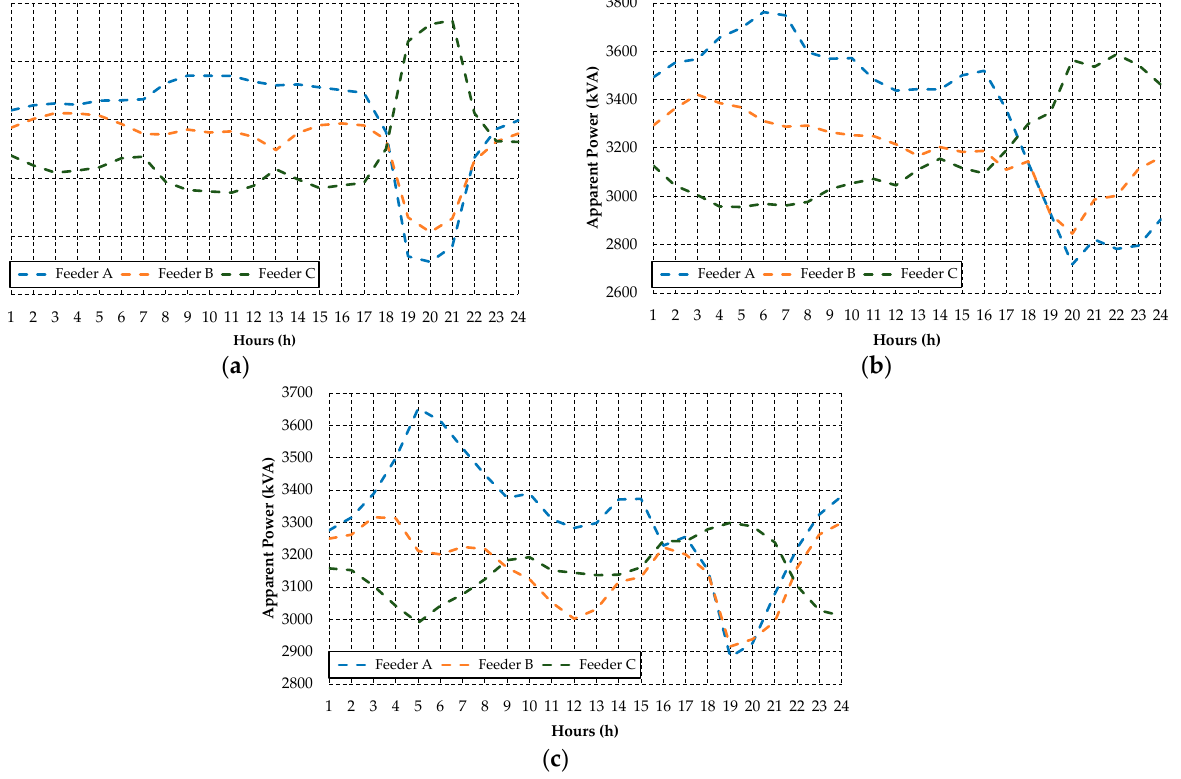
Figure 9. Maximum daily limit curves for the excessive loading condition on rural feeders for ( a ) weekday, ( b ) Saturday, and ( c ) Sunday. Source: The authors.